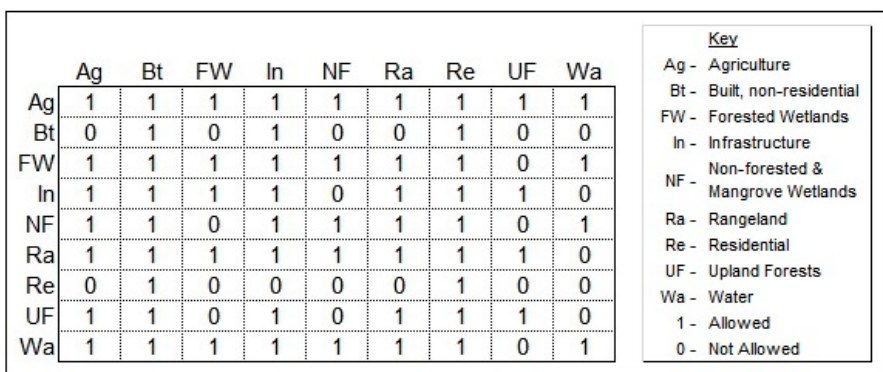
Figure A5. Transition sequences matrix showing possible LULC class conversions.